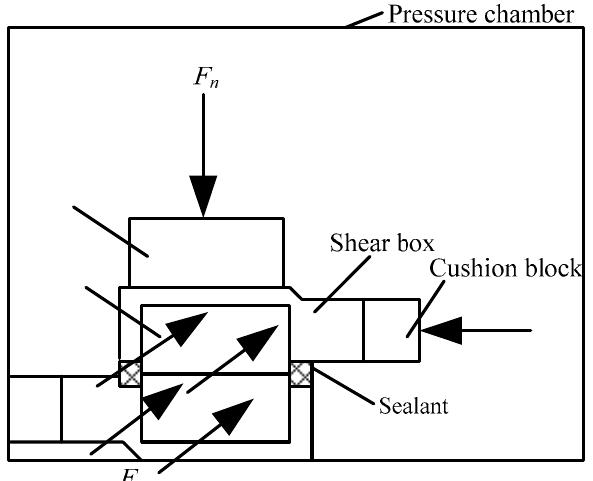
Figure 7. Loading diagram of shear test. Table 3. The shear test loading